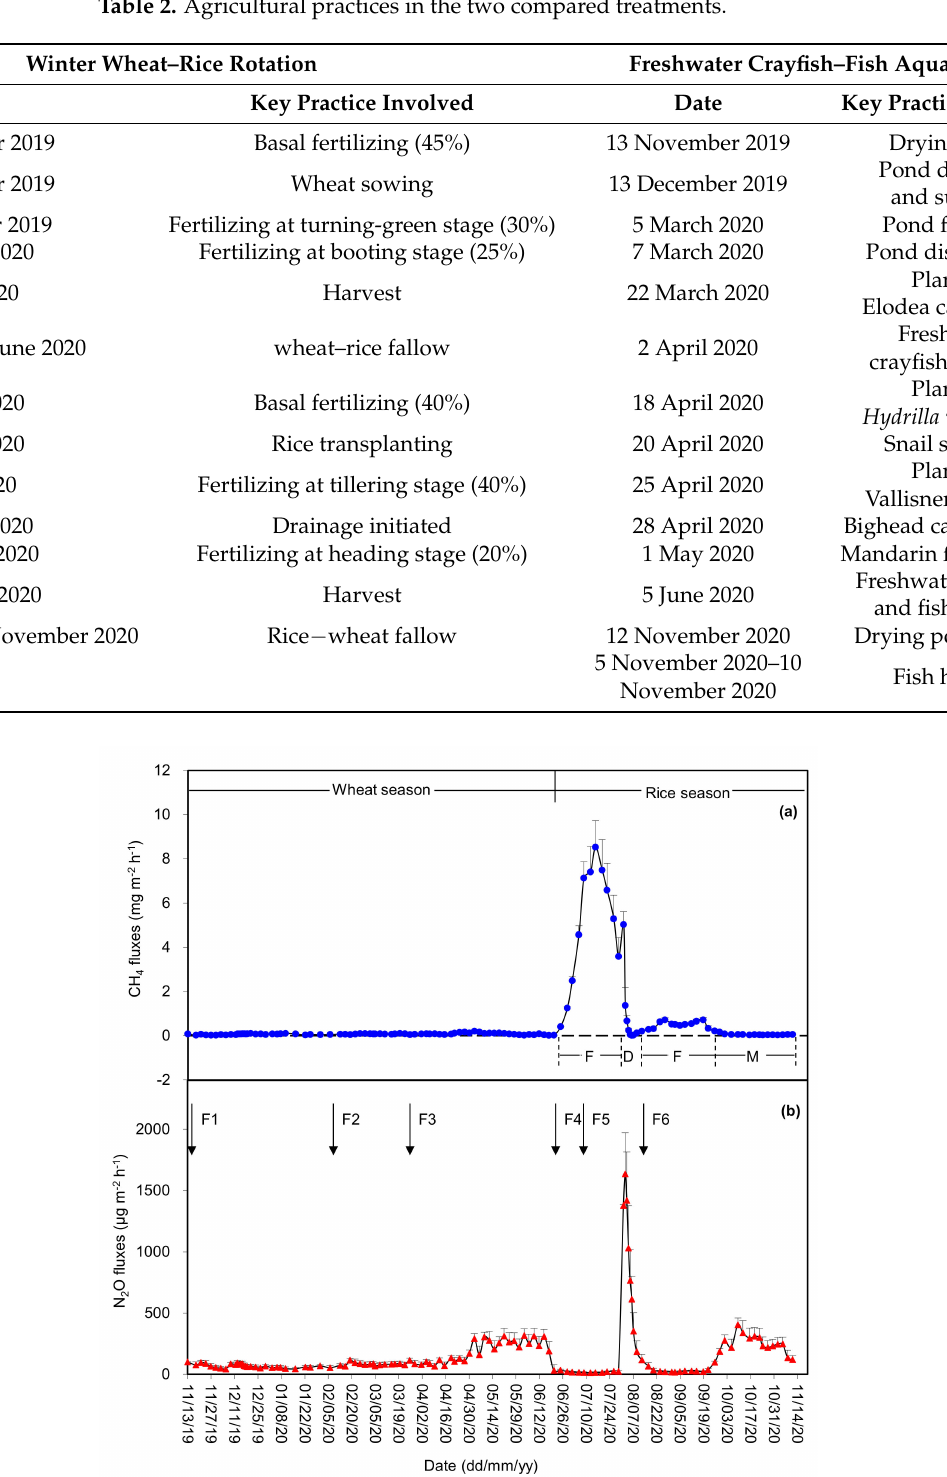
Table 2. Agricultural practices in the two compared treatments.